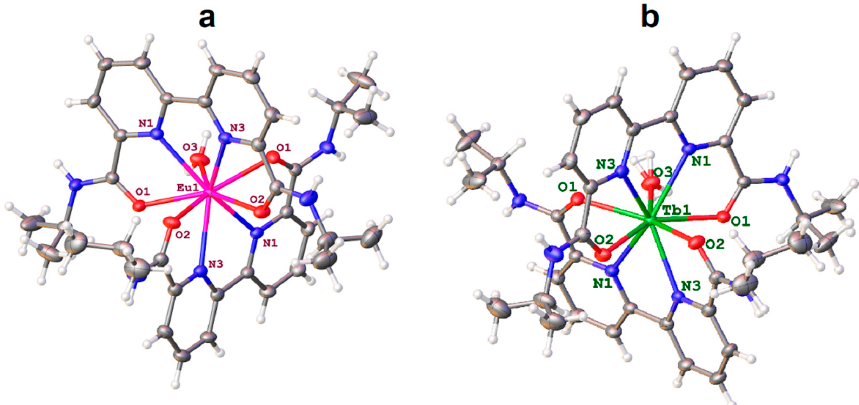
Figure 1. Molecular structures of the inner spheres of [Eu(BDCA) 2 (H 2 O)]Cl 3 ( a ) and [Tb(BDCA) 2 (H 2 O)]Cl 3 ( b ) with thermal ellipsoids shown at the 50% probability level. The Cl – anions and water molecules of the outer spheres of the complexes are omitted for better representability.